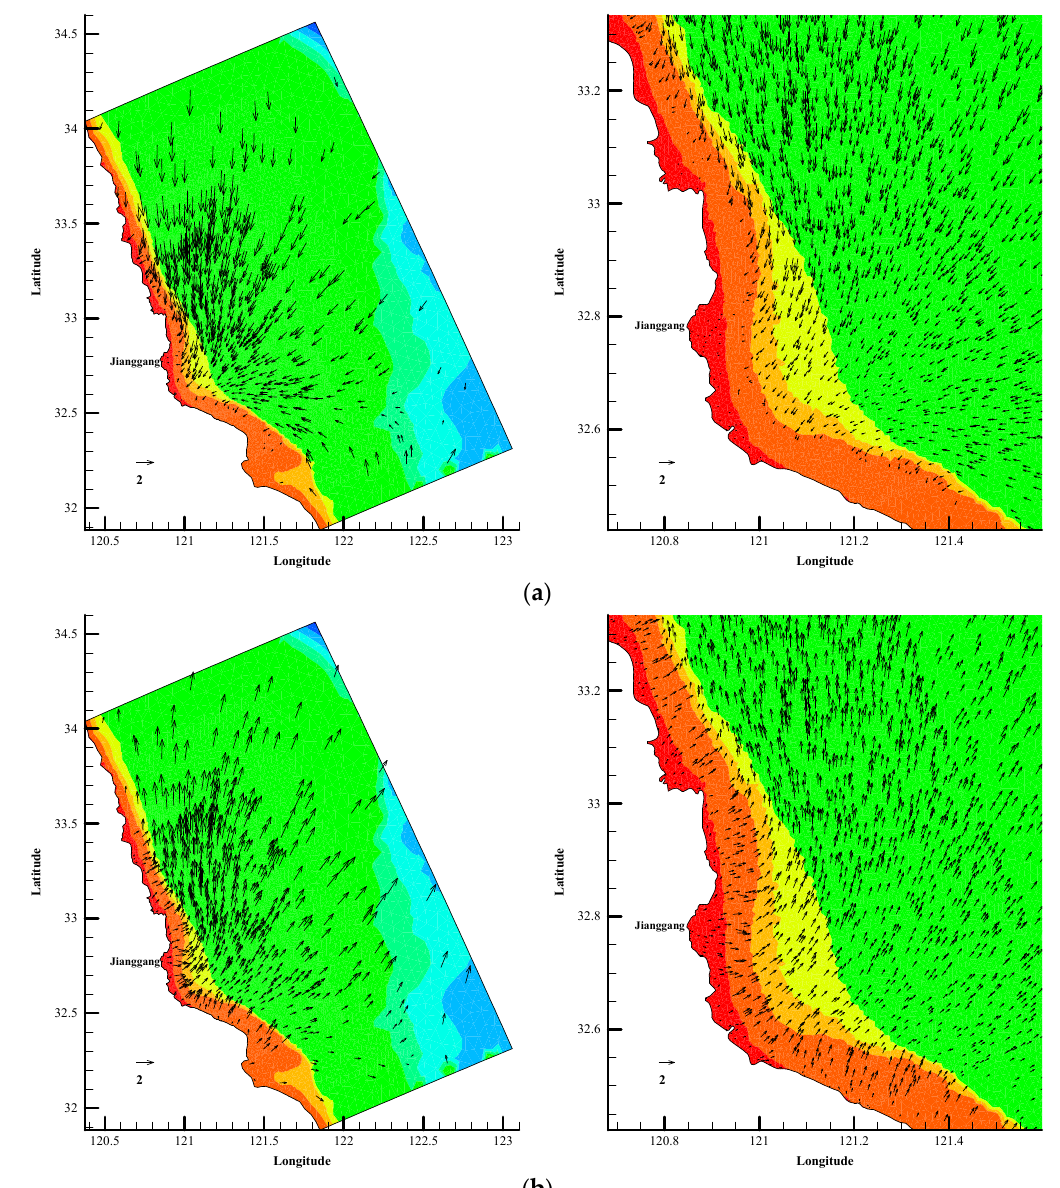
Figure 8. Maximum flood and ebb current fields when there are no RSRs (the base map shows the topography: left is the global tidal current field and right is the local tidal current field); ( a ) Maximum flood; ( b ) Maximum ebb.